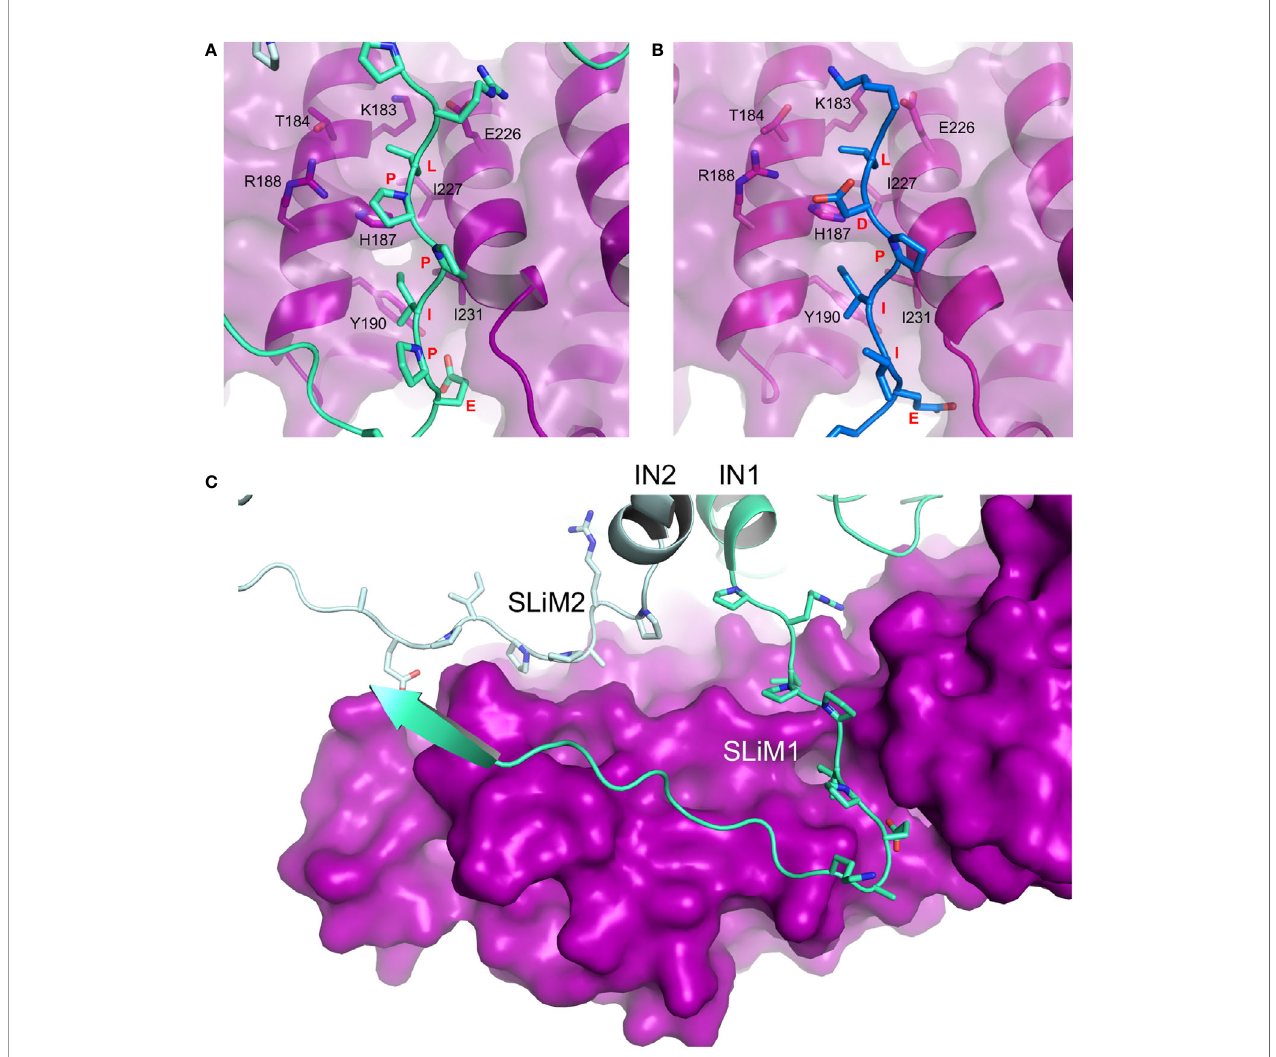
FIGURE 2 | Hijacking of PP2A via the B56-binding LxxIxE SLiM. (A) Details of LPPIPE IN SLiM (equivalent to SLiM1 in panel C; green) binding to the canonical LxxIxE-binding groove on B56 (purple). Interacting residues are shown as sticks (PDB ID: 6Z2Y). (B) BUBR1 LDPIIE SLiM (also equivalent to SLiM1 in panel C; blue) binding to the same site on B56 (purple) (PDB ID: 5JJA). In this case, the aspartate was used as a phosphomimetic. The conformational overlap between residues of the SLiMs and the binding groove in both structures is evident. (C) Deltaretroviral integrase (IN) dimer contributes two identical SLiM regions to bind one molecule of B56 (purple) at two different sites. Each IN chain (IN1 and IN2) is coloured with a different shade of green (PDB ID: 6Z2Y, EMDB: 11052). PyMOL software was used for